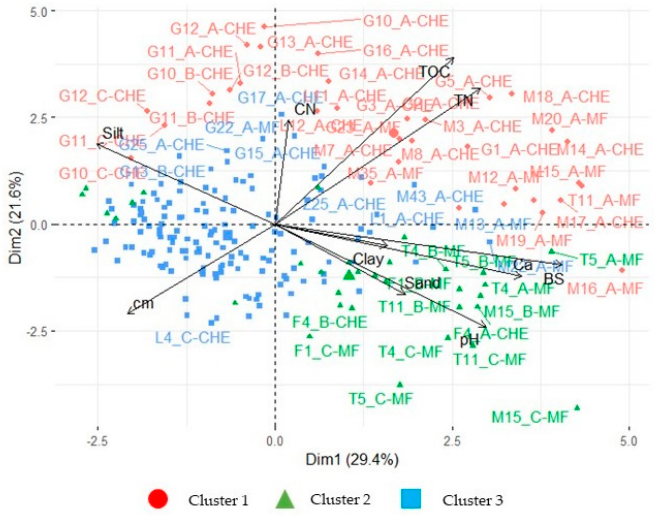
Figure 2. Principal component analysis (PCA) obtained from the dataset at a 400–1000 m altitudinal range. The distinct colors indicate the three clusters distributed along the principal component (Dim) 1 and 2. The sample codes included the sampling area, profile number, layers, and vegetation cover. The variables are in black. BS = base saturation; Ca = exchangeable Ca; TN = total N; OC = soil organic C; CN = OC–to–N ratio; cm = microbial biomass C.